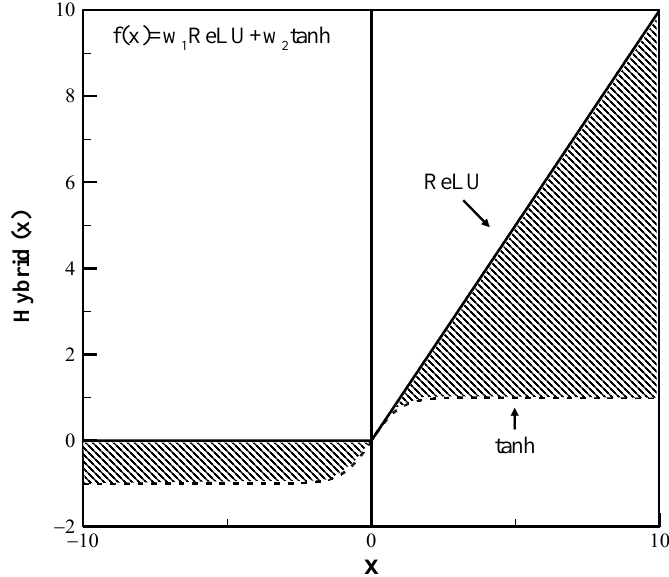
Figure 1. Hybrid activation function (Dash line: hyperbolic tangent activation function, Line: ReLU activation function, Hatched Area: hybrid activation function).